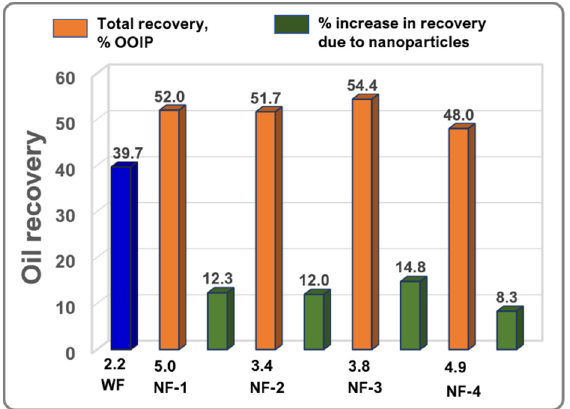
Figure 4. Secondary oil recoveries from various nanofluids compared to the reference waterflood. The numbers on the X -axis show average pore volumes injected to reach ultimate oil production.